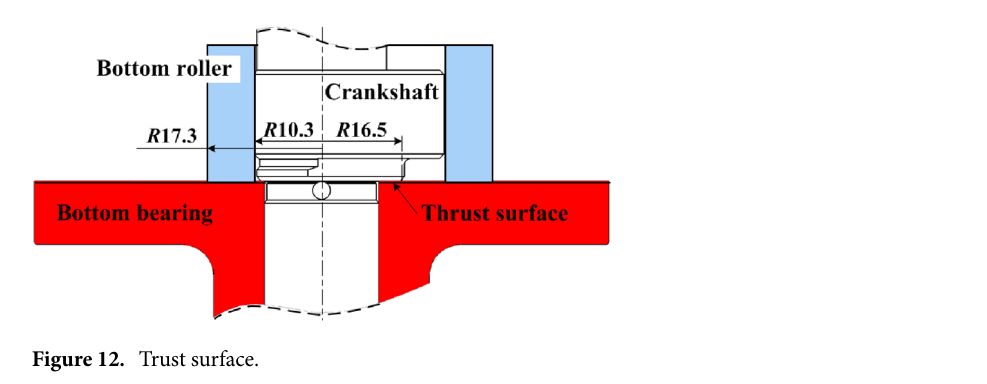
Figure 12. Trust surface.